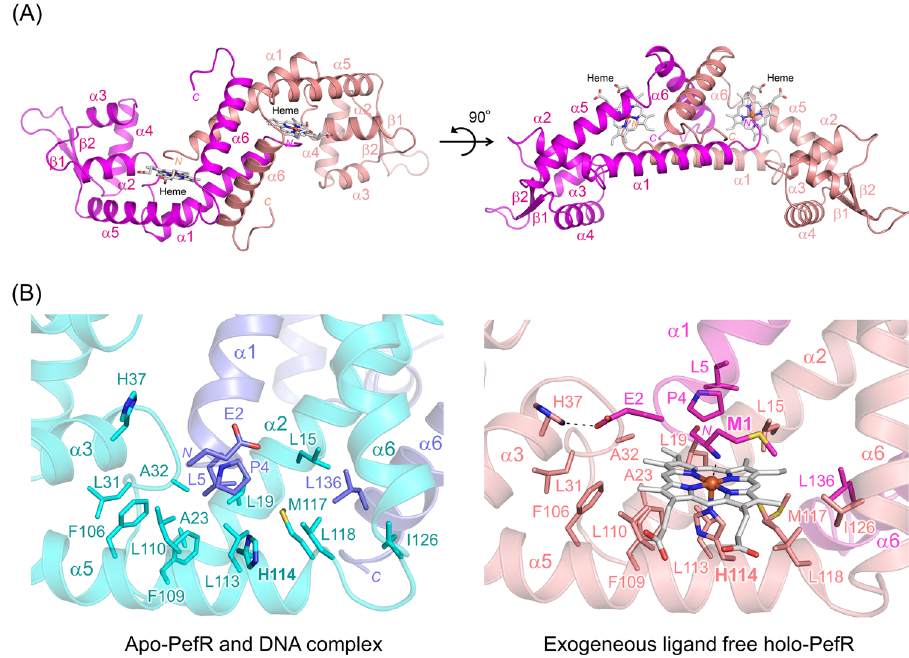
Fig. 5 Crystal structures of holo-PefR. A Overall structures of exogenous ligand-free holo-PefR are showed in magenta and pink. B Structures of the heme- binding sites in the apo-PefR – DNA complex (left panel), and in exogenous ligand-free holo-PefR (right panel). Hydrophobic residues and heme axial ligands are represented by